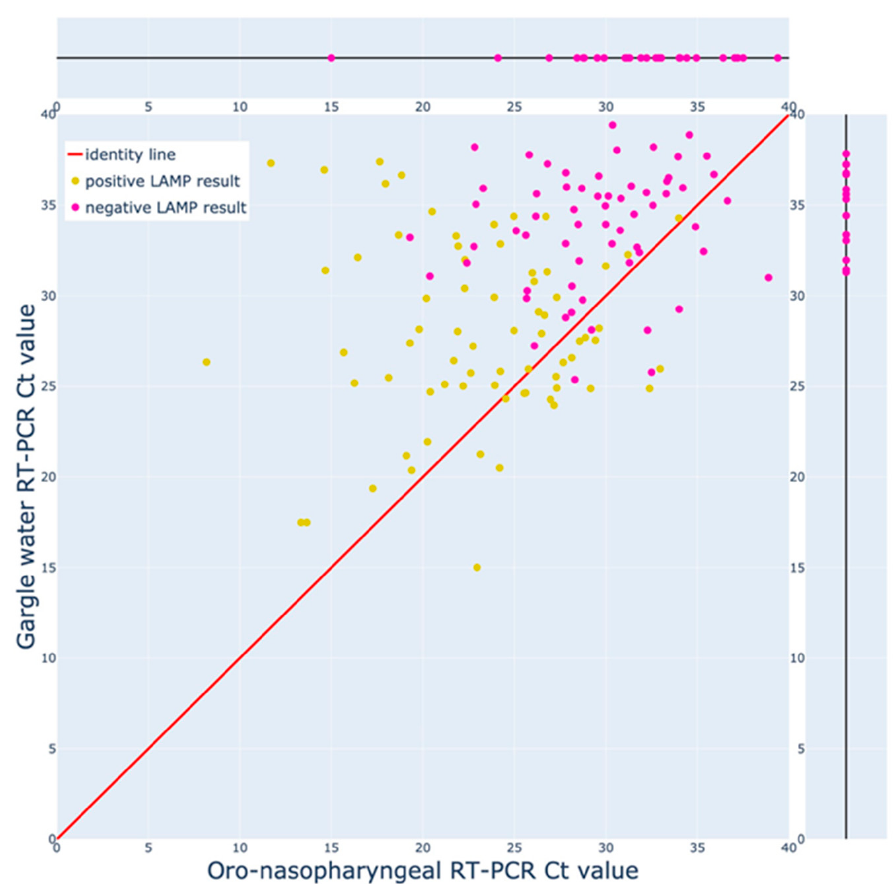
Figure 2. The RT ‐ PCR Ct values and LAMP results for sample pairs with at least one positive RT ‐ PCR result. The sample pairs where both the gargle water and swab yielded positive (sub 40 Ct) indirect RT ‐ PCR results are distributed across the bottom left 2 ‐ D plane. For sample pairs where only one out of the two samples yielded a positive RT ‐ PCR result, the corresponding data ‐ point is situated on the 1 ‐ D line indicating its Ct value. For all data points, the color of the point indicates the gargle water LAMP result, with yellow corresponding to a positive result and purple to a negative result.